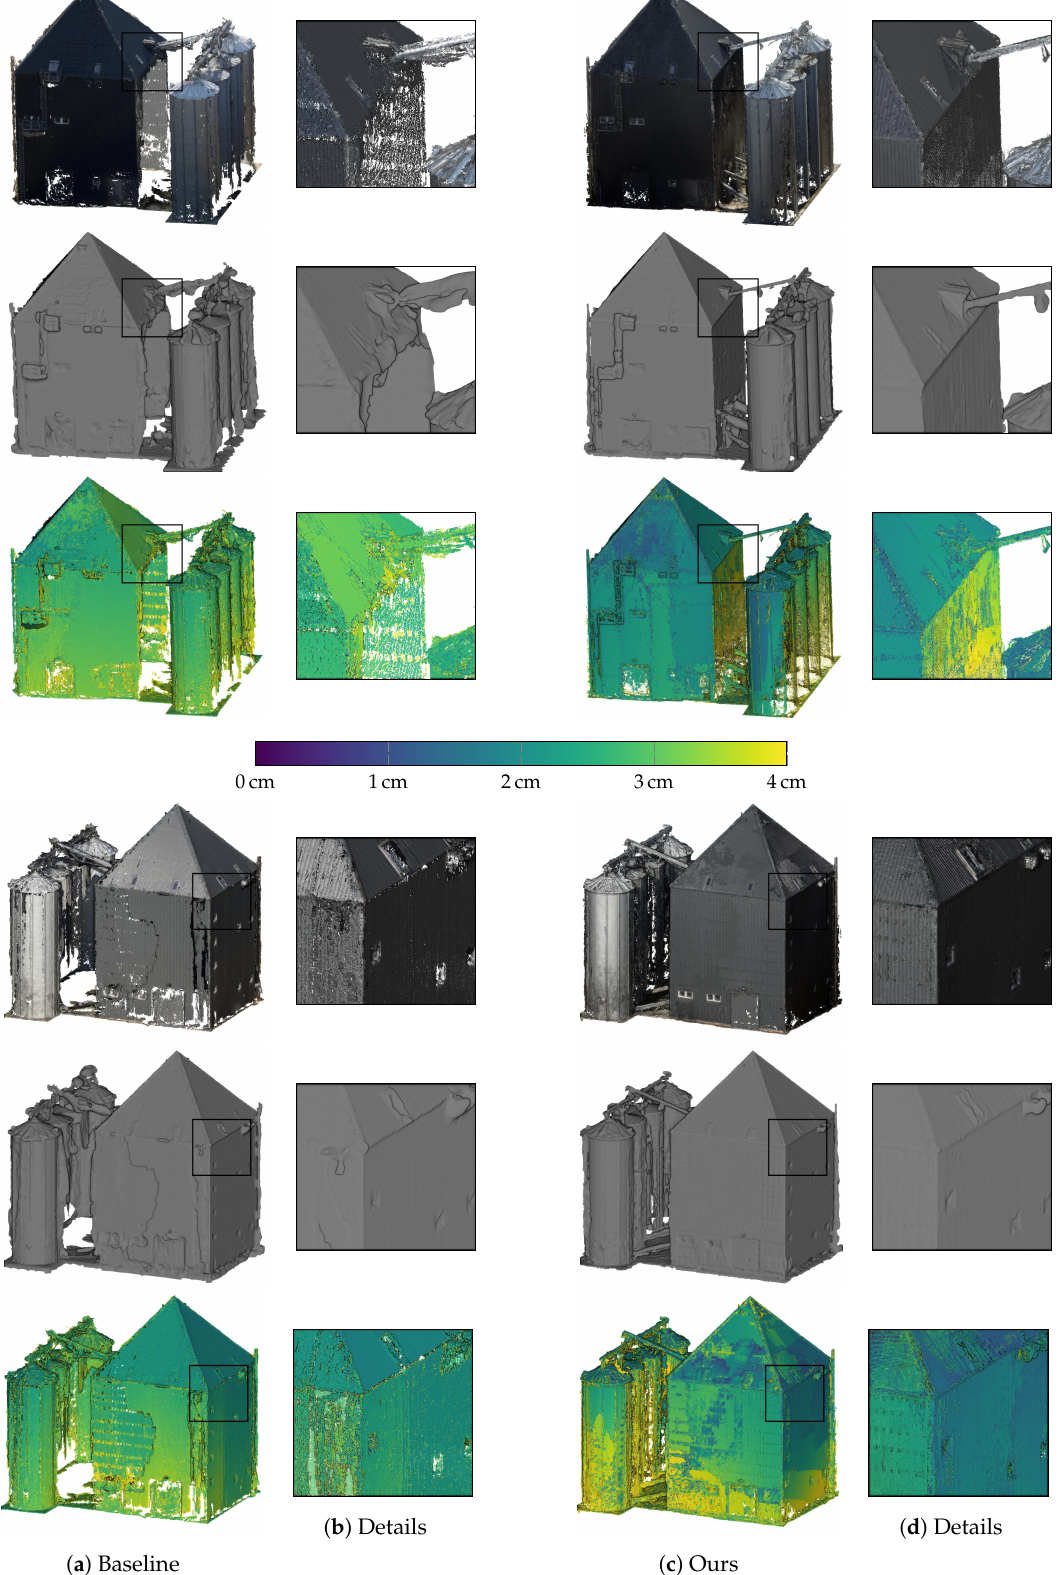
Figure 13. Qualitative reconstruction results for the silo scene using a baseline UAV path ( a ) and our optimized path ( c ). Rows show the densified point cloud ( top ), a triangulated mesh ( mid ) and the point density ( bottom ). Two different viewpoints are visualized which are separated by the colormap of the point density, showing the closest distances between adjacent 3D